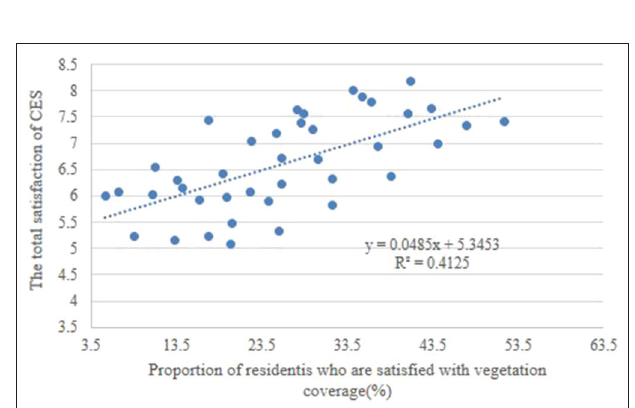
FIGURE 4 | Proportion of respondents who are concerned about the future quality of residential green spaces.